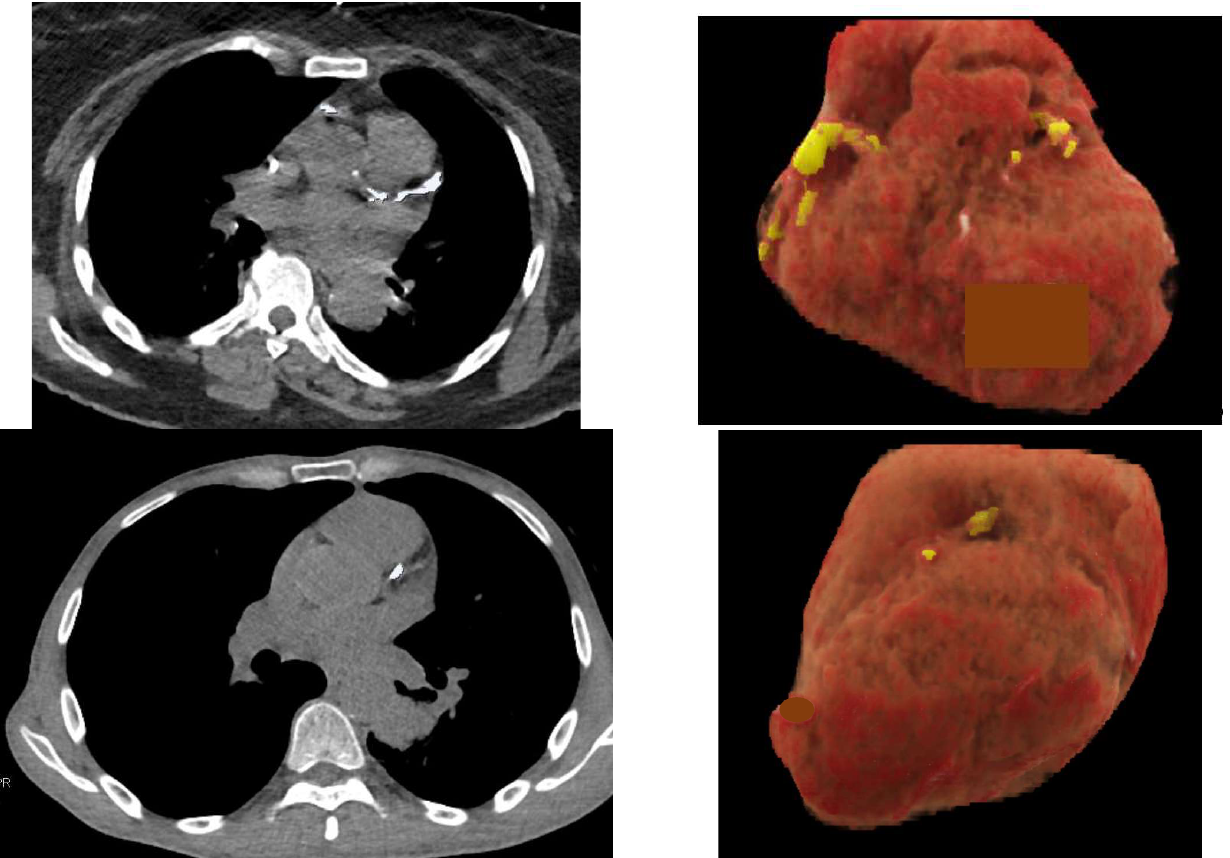
Figure 3. Ungated non contrast chest CT scans in two different smokers with automatic quantification of coronary artery calcifications (CAC) and heart volume using the AI-RAD Companion (Siemens Healthinners) software. Axial CT images show the CAC ( left ) and coronal 3D projection of the heart ( right ) that shows the segmented CAC (yellow). The total CAC and heart volumes were 1175 mm 3 (category IV) and 620 mL, respectively, in the first subject ( top ), and 187 mm 3 (category III) and 832 mL, respectively, in the second ( bottom